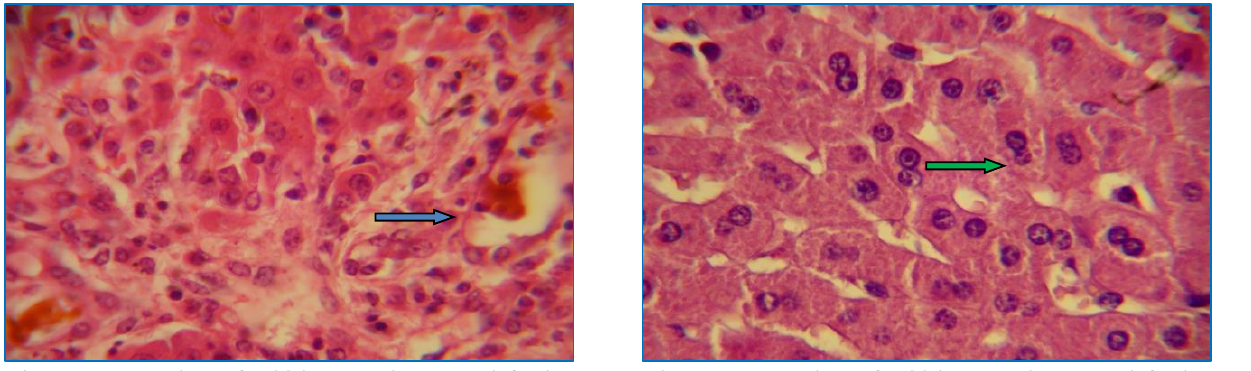
Figure, 7: G2: Liver of rabbit at 30 days post infection show deposition of bile pigment ( ) (H and E 40x).